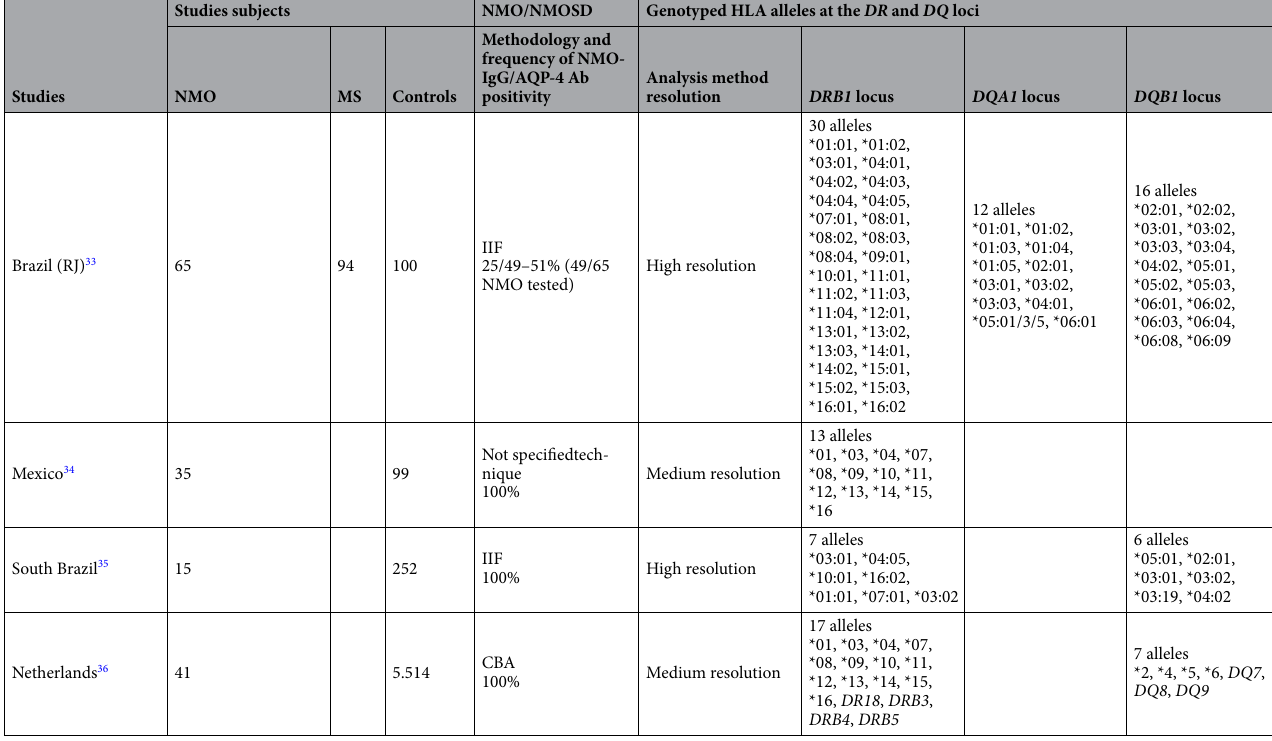
Table 2. Subjects collected data and genotyped HLA Class II alleles. NMO NeuromyelitisOptica, NMOSD NeuromyelitisOpticaSpectrum Disorders, MS Multiple Sclerosis, IgG Immunoglobulin G, AQP-4 Aquaporin-4, HLA Human LeukocyteAntigen, RON RecurrentOptic Neuritis, BRON Bilateral RecurrentOptic Neuritis, LETM Longitudinal ExtensiveTransverseMyelitis, SP São Paulo, RJ Rio de Janeiro,